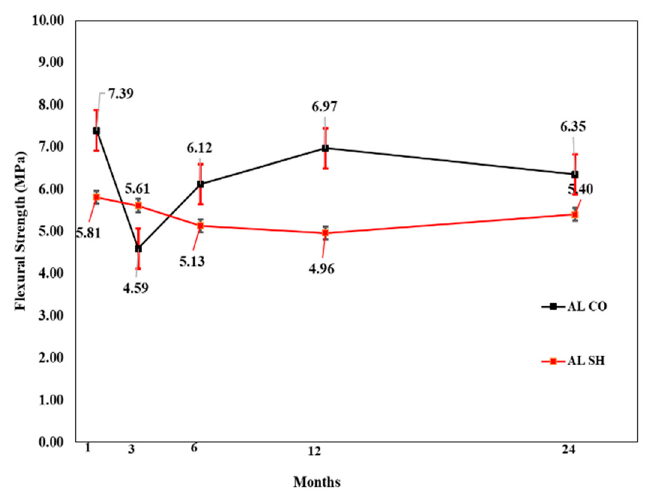
Figure 18. AL accelerator mix flexural strength by age.